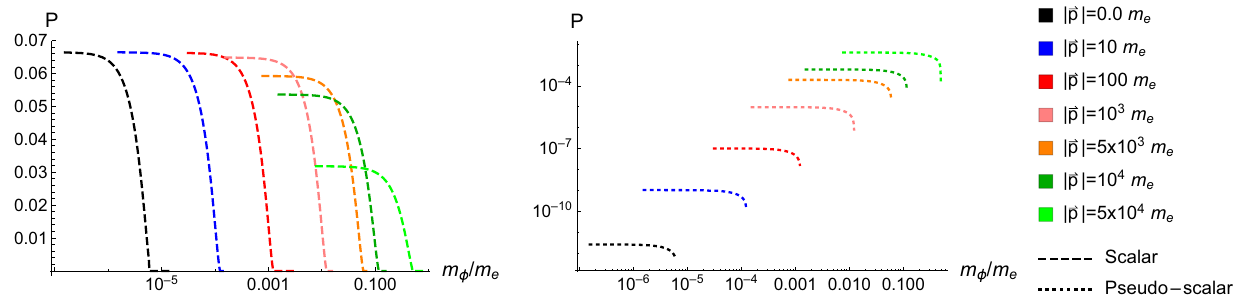
Fig. 2 The total yield is plotted against the mass of the emitted ALP for various seed electron energies